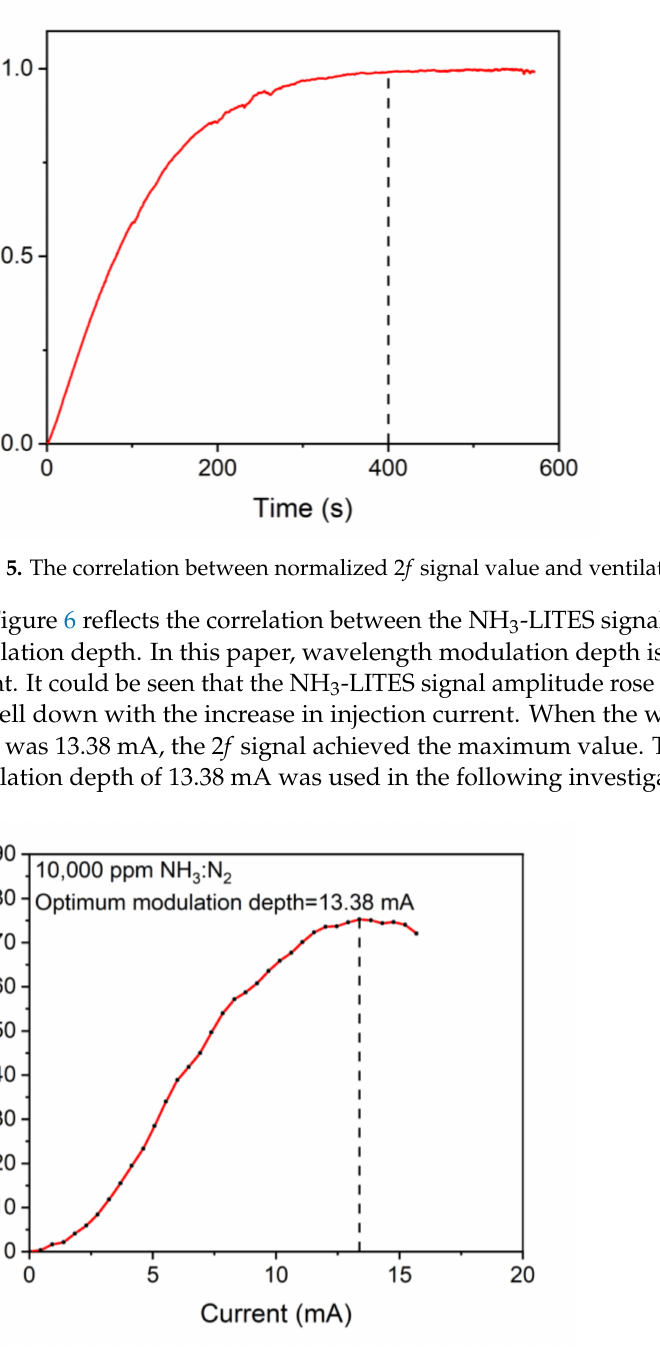
Figure 6. The correlation between wavelength modulation depth and 2 f signal